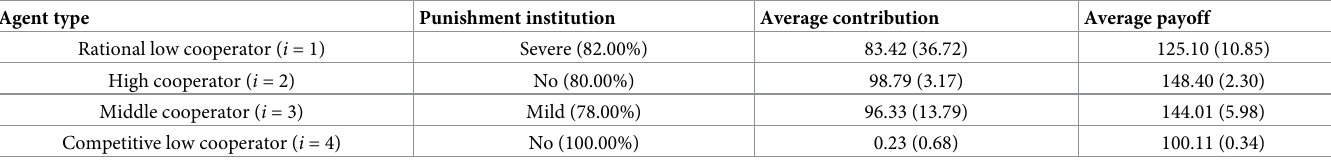
Table 6. Contributions and payoffs under endogenous punishment in the last 50 periods of 50 simulation runs. Agent